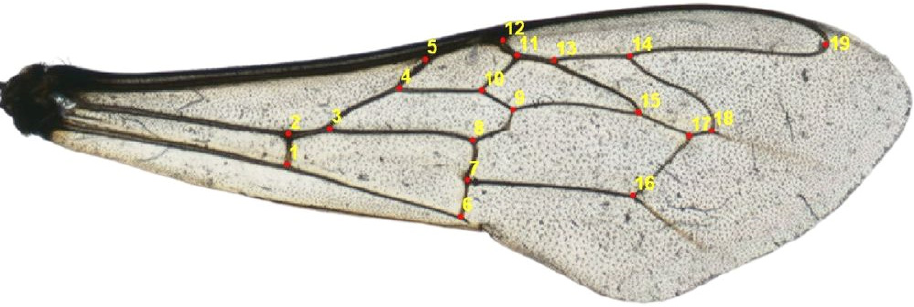
Figure 2. Location of 19 landmarks at venal intersections of the left forewing of Apis mellifera worker. Additionally, we included fifty images of the left anterior wing from each